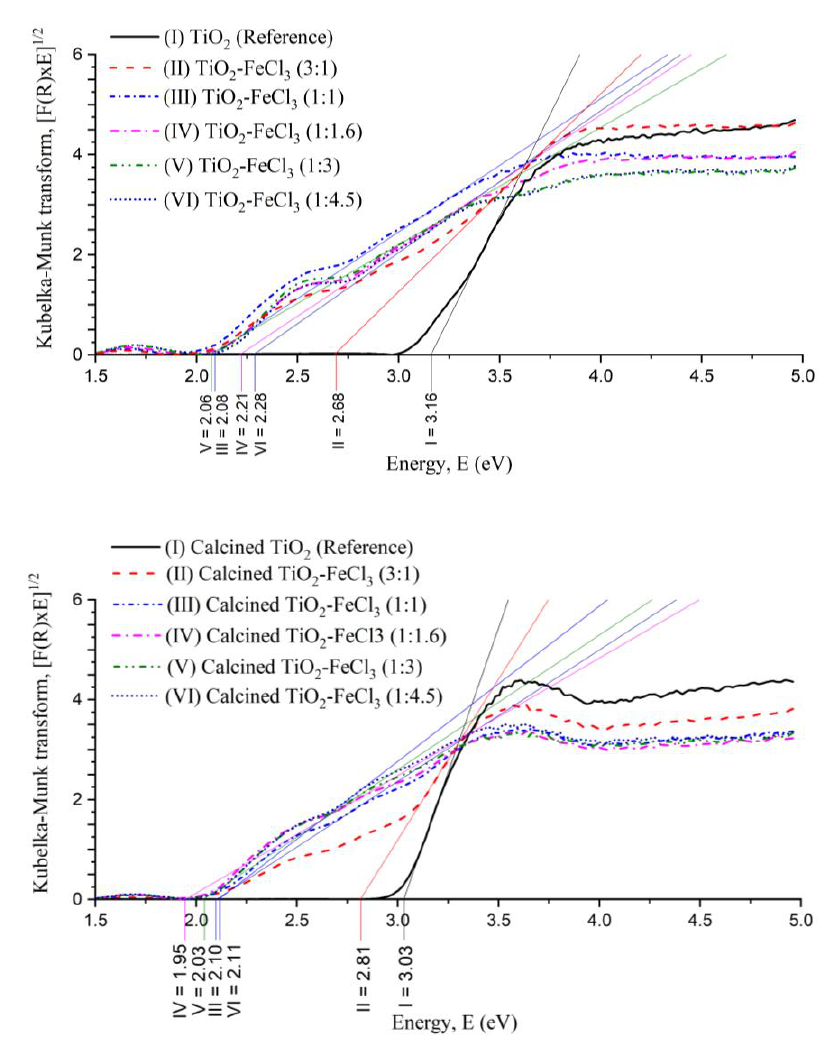
Figure 5. Plot of Kubelka–Munk transform versus the Energy of the light absorbed for the undoped TiO 2 (reference) and the samples synthesized before calcination ( top ) and after calcination ( bottom ). Therefore, the incorporation of Fe 3+ into the TiO 2 lattice causes a decrease in the energy band gaps. This effect is observed comparing the reference TiO 2 with the TiO 2 -FeCl 3 ratio (1:1). Its bang gap energy decreases from 3.16 eV to 2.08